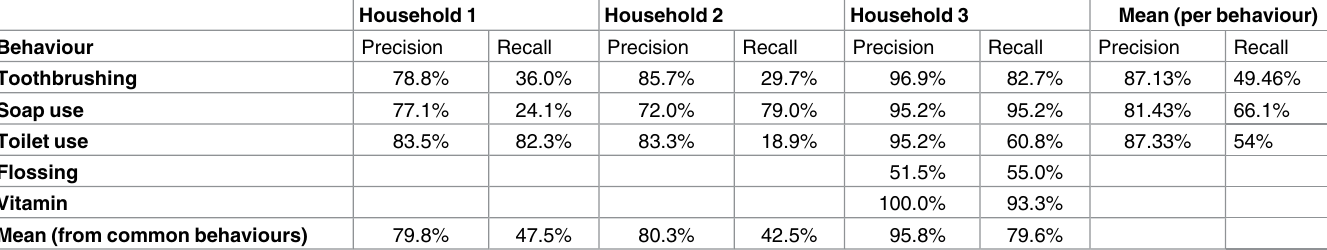
Table 5. Mean precision and recall rates across the two raters, split by behaviour and